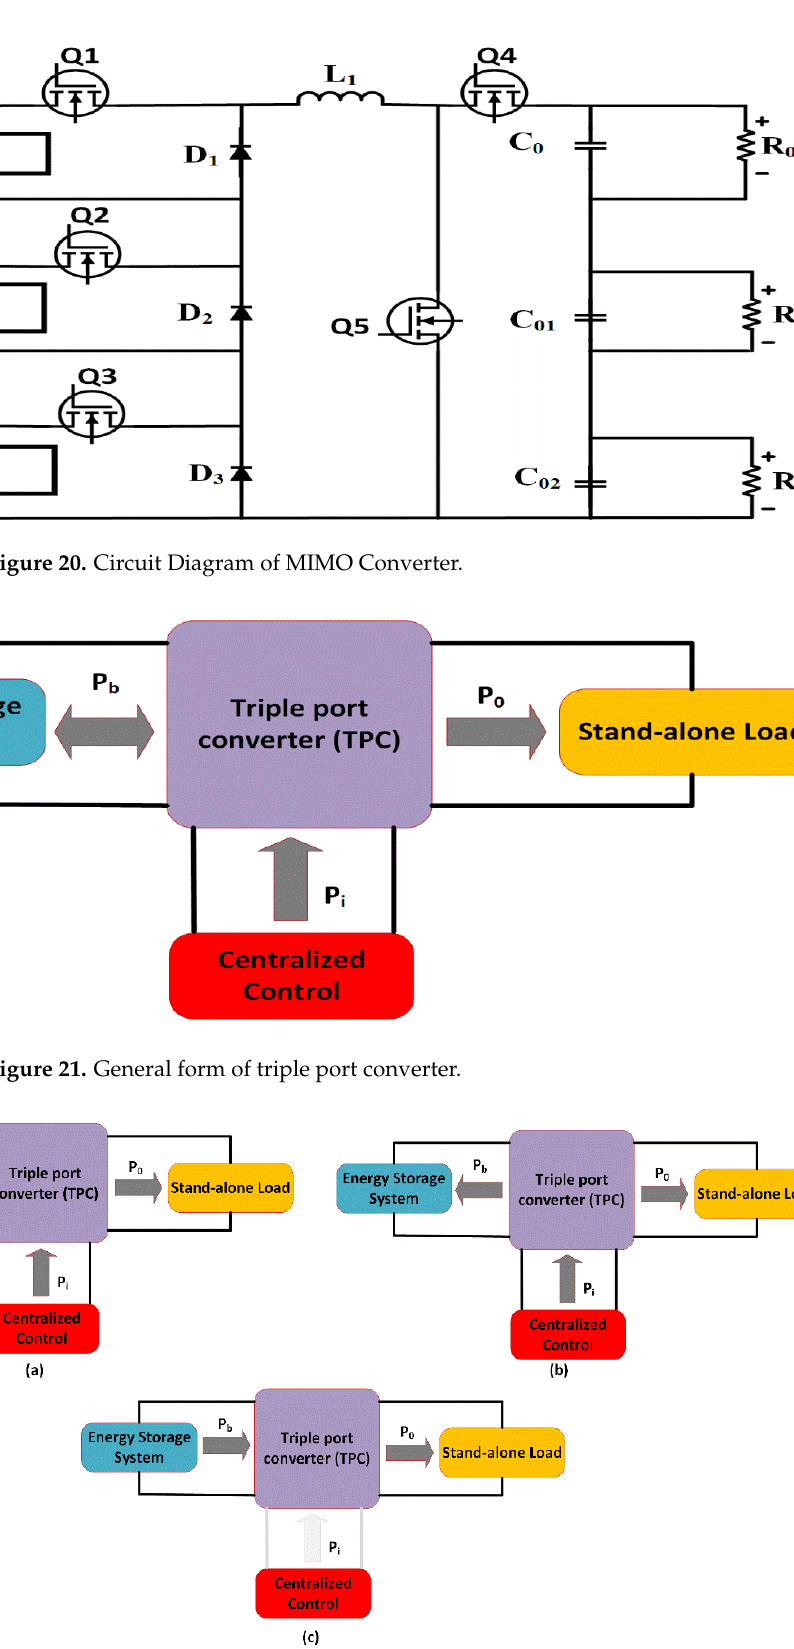
Figure 23. NI three-port buck–boost Converters. Recent research has piqued interest in TPC. The three ports are the voltage port, stor- age port, and load or output port. There are three modes of operation for this converter: DI, DO, and SISO. If the load obtains power from both the battery and the input source, then it operates as a DI converter. The converter is in DO mode if the load and batteries consume all the power. In a MIMO, the load can be powered by an input source or a battery. Increased efficiency, small size, dependability, and effective power management are all advantages of this design. These are commonly employed in renewable energy systems because of their advantages [71,72]. An NI-TPC that connects the PV, battery, and load is described. A higher power density and dependability are attained with fewer con- version stages, as evidenced by experimental data. [73,74] introduce a family of NI-TPCs. In a DI converter or DO converter, a SISO converter is used to create these TPCs. This explains the development of a systematic process to derive TPCs from DI and DO con-